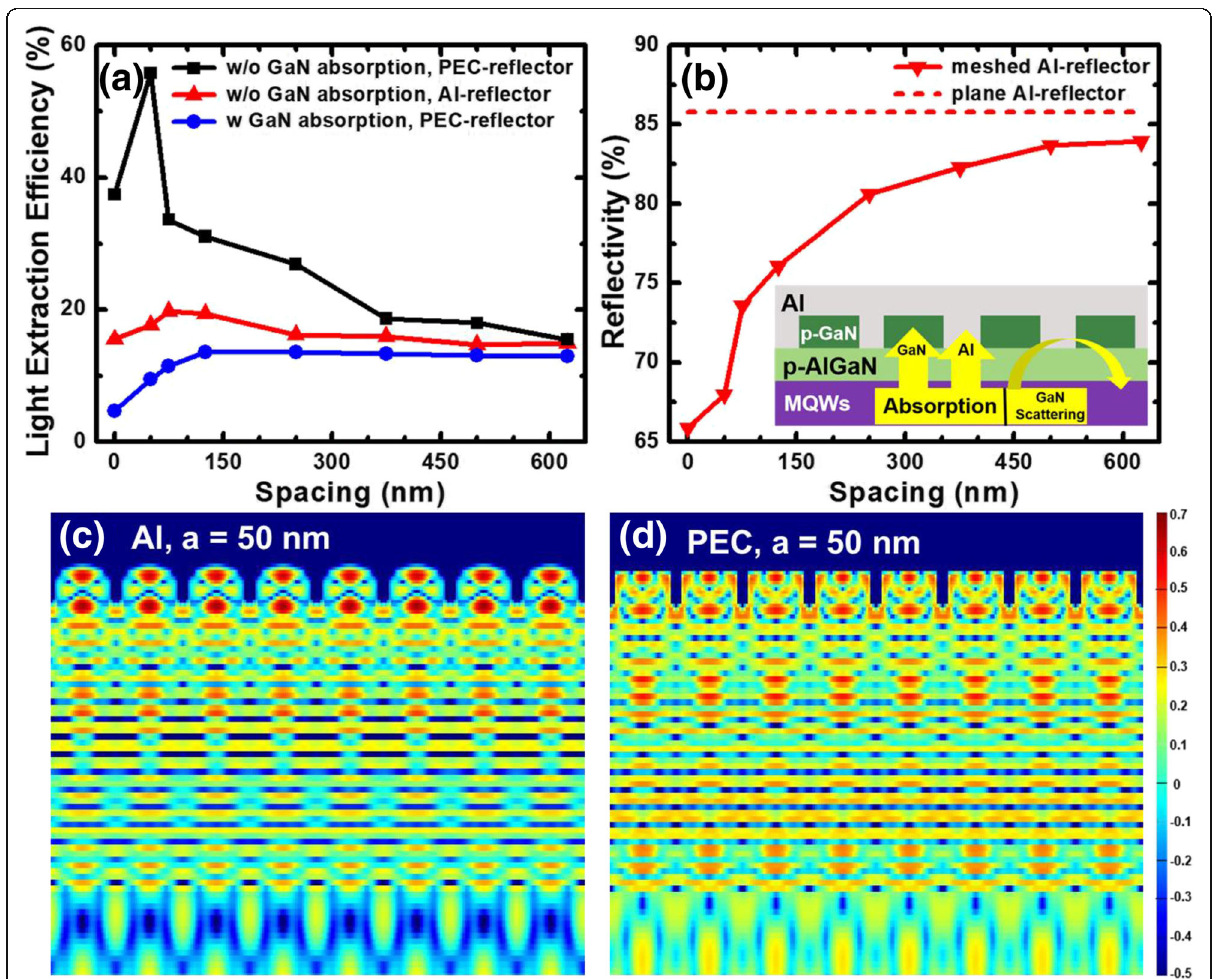
Fig. 3 a LEEs as a function of the nanorod spacing for DUV LEDs with the 100-nm-high non-absorptive/absorptive p-GaN nanorods, and the reflectors are Al and PEC, respectively. b Reflectivity of normal incidence with meshed Al reflector and plane Al reflector as a function of the nanorod spacing. The inset shows the effect of p-GaN layer absorption, Al metal absorption, and structure scattering in DUV LED with meshed p- GaN contacts. Cross-sectional distributions of electric field at the nanorod spacing of 50 nm with c Al and d PEC